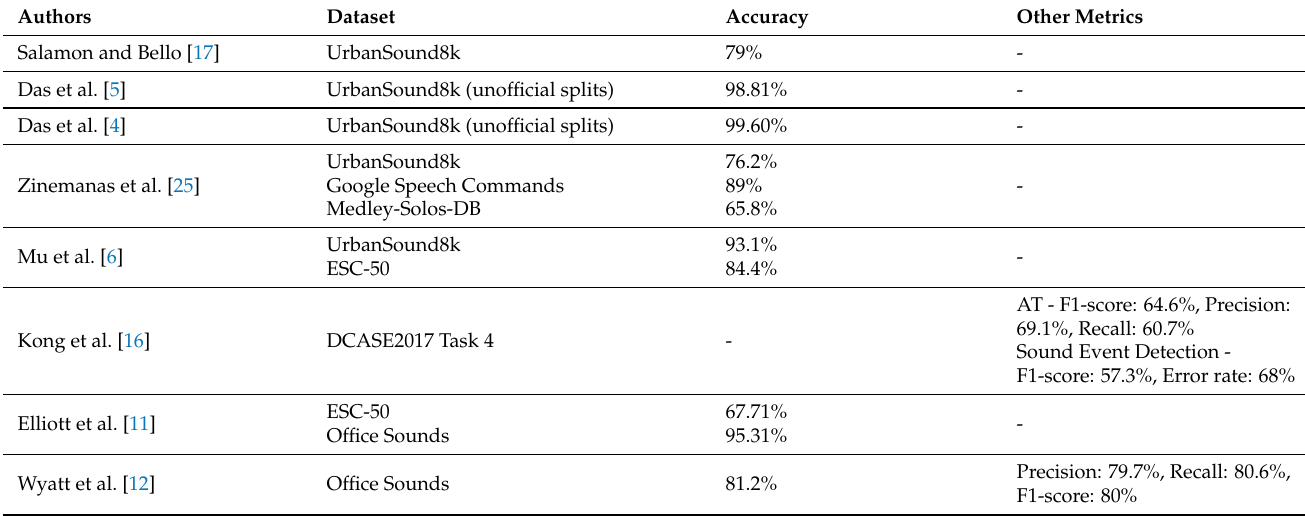
Table 7 resumes the results of all of the articles included in this literature review. Table 7. Results summary of all models included in this literature